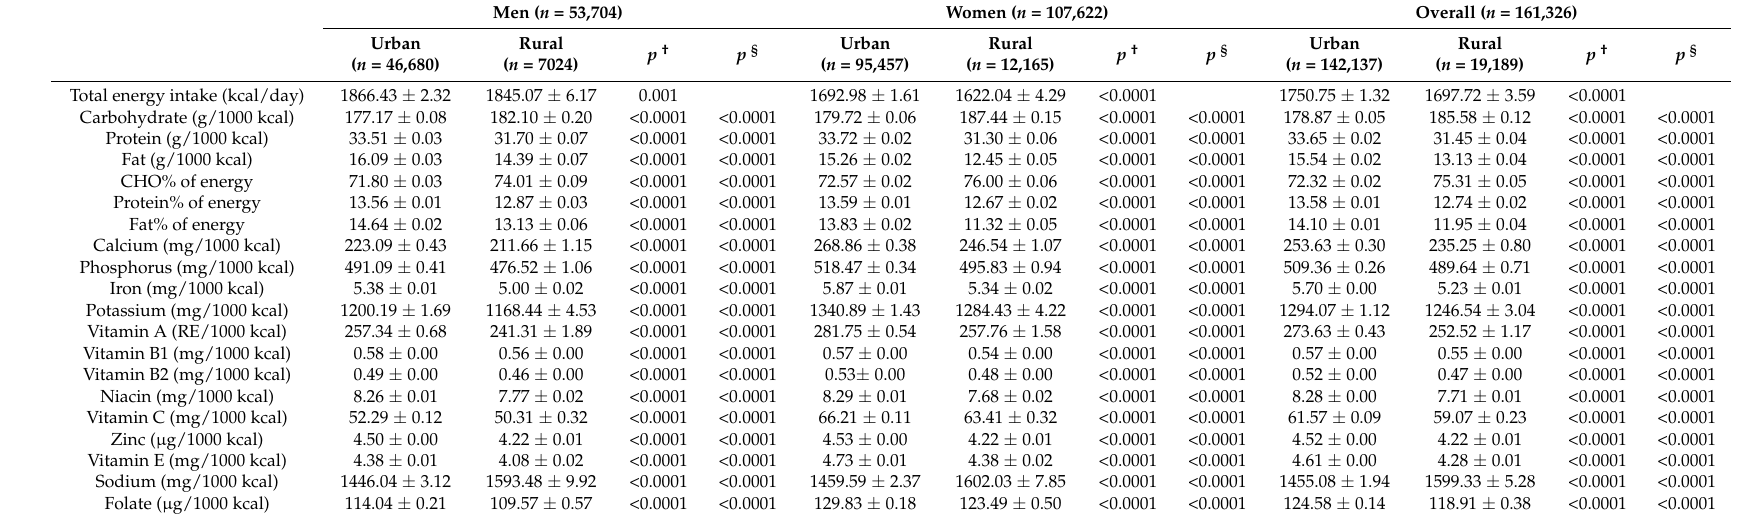
Table 3. Daily nutrients intake of rural and urban Korean